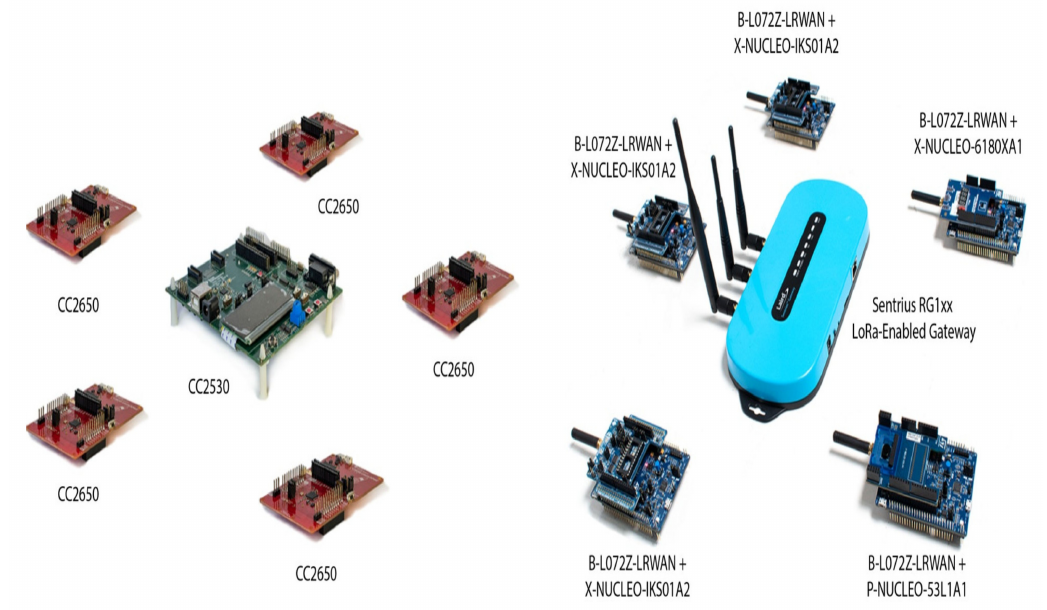
Figure 6. Network topologies under Zigbee and WiFi